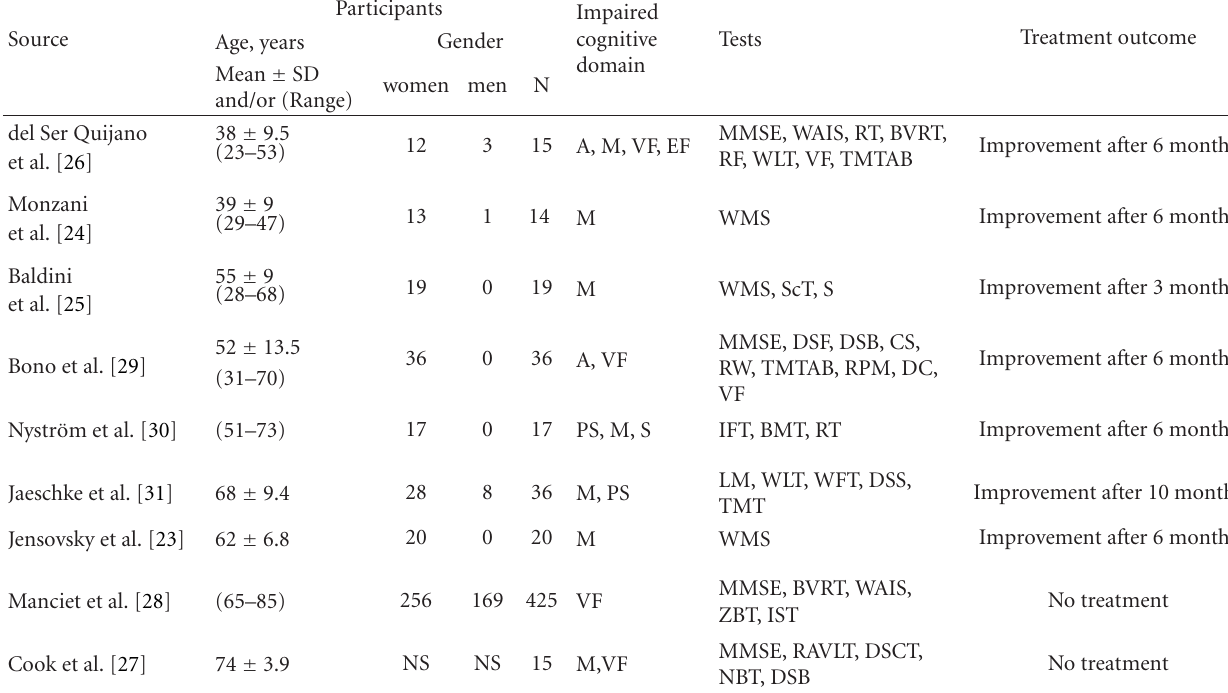
Table 3: Cognitive impairment in subclinical hypothyroidism (A: attention; BMT: Bingley’s memory test; BVRT: Benton’s visual retention test; CS: Corsi’s span forward and backward; DC: drawing copy; DSB: digit span backward; DSCT: digit symbol coding test from the